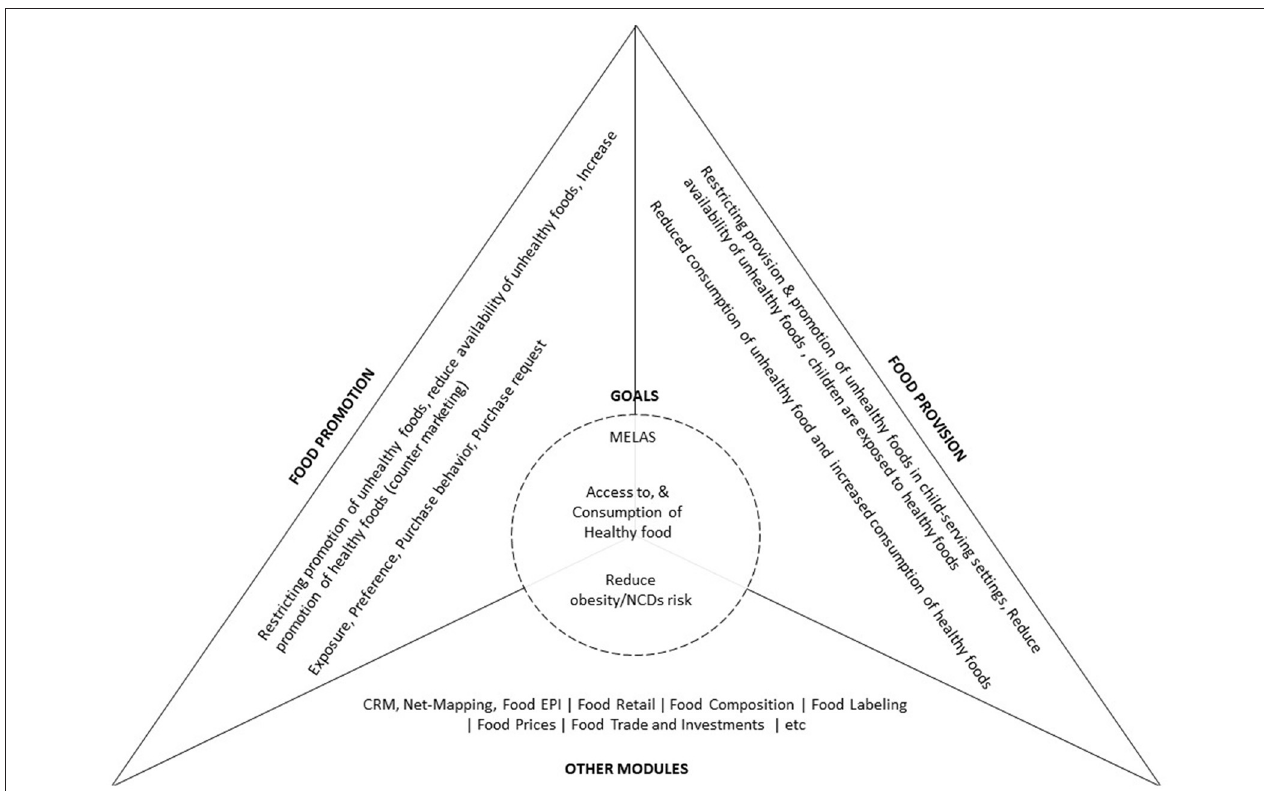
FIGURE 1 | Conceptual framework for the MEALS4NCDs project. The top two triangles (to the left, and right) depict the INFORMAS-related work packages to be deployed in the study, their respective approaches and desired outcomes. The base triangle depicts INFORMAS modules already completed (Food-EPI), non-INFORMAS approaches (CRM, and Net-Mapping), and modules to be implemented in future. Implementation of all work packages contribute to the MEALS4NCDs desired short-term goals (adaptation and deployment of the modules–within 3 years); and long-term goals (institutionalization efforts, and as listed in the circle to be achieved after the 3-year project